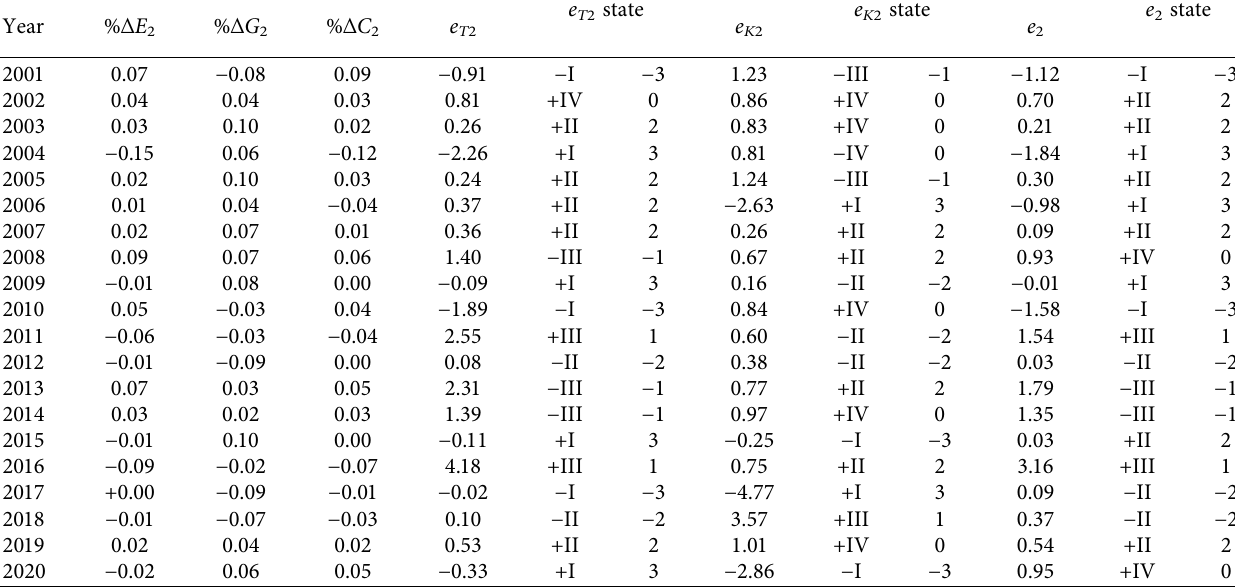
Table 9: Decoupling index and decoupling relationship of the petroleum and natural gas sector from 2001 to 2020.